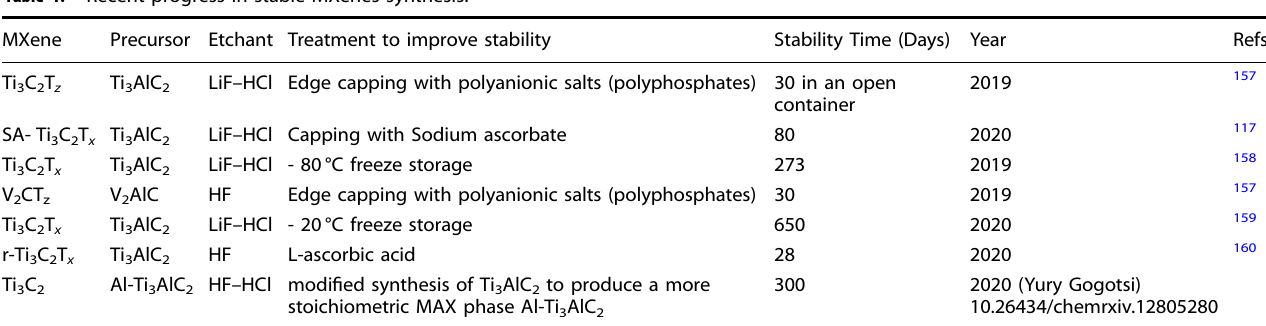
Table 1. Recent progress in stable MXenes